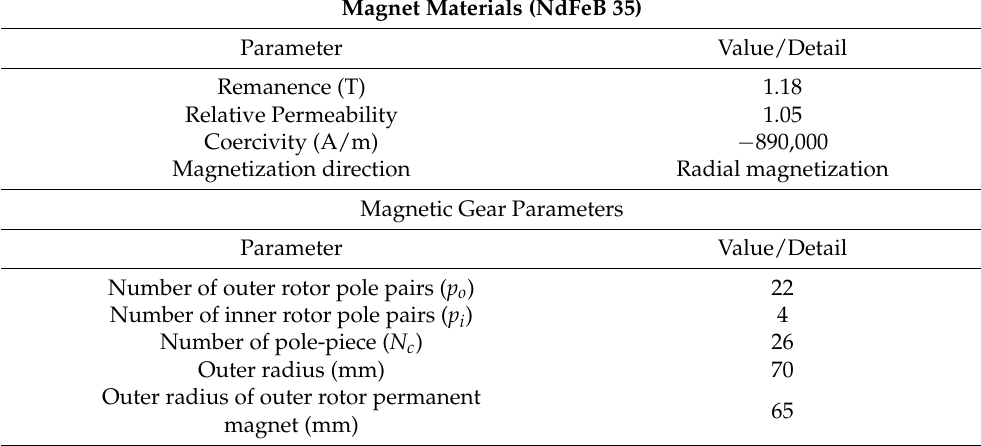
Figure 15. Rotational speed when the outer rotor and pole-piece set as constant. The final design parameters achieved from the above design steps have been analyzed. Therefore, the final design of CMGT for wind turbine applications with two input links and one output link can be seen in Table 9. Table 9. Final design